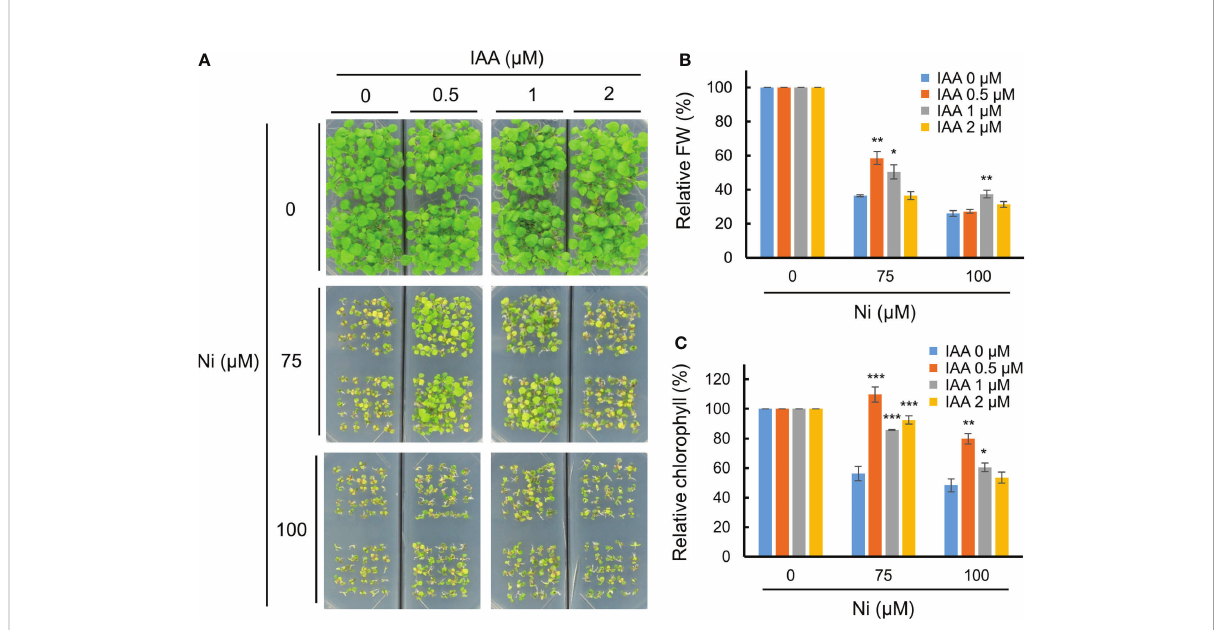
FIGURE 1 Exogenous auxin partially enhanced Ni stress tolerance. (A) Phenotypes of wild-type (WT, Col-0) plants subjected to various Ni concentrations combined with different IAA concentrations. WT plants were grown in a half-strength MS medium containing different concentrations of Ni and IAA and photographed at 2.5 weeks after germination. Relative fresh weight (FW, B ) and relative chlorophyll contents (C) in leaves of plants exposed to 0, 75, or 100 m M Ni with or without 0, 0.5, 1, and 2 m M IAA for 2.5 weeks. Values are means ± SE of three independent biological replicates. Asterisks indicate signi fi cant differences (* p < 0.05, ** p < 0.01, and *** p < 0.001) from the 0 µM IAA treatments at each Ni concentration determined using two-tailed Student ’ s t